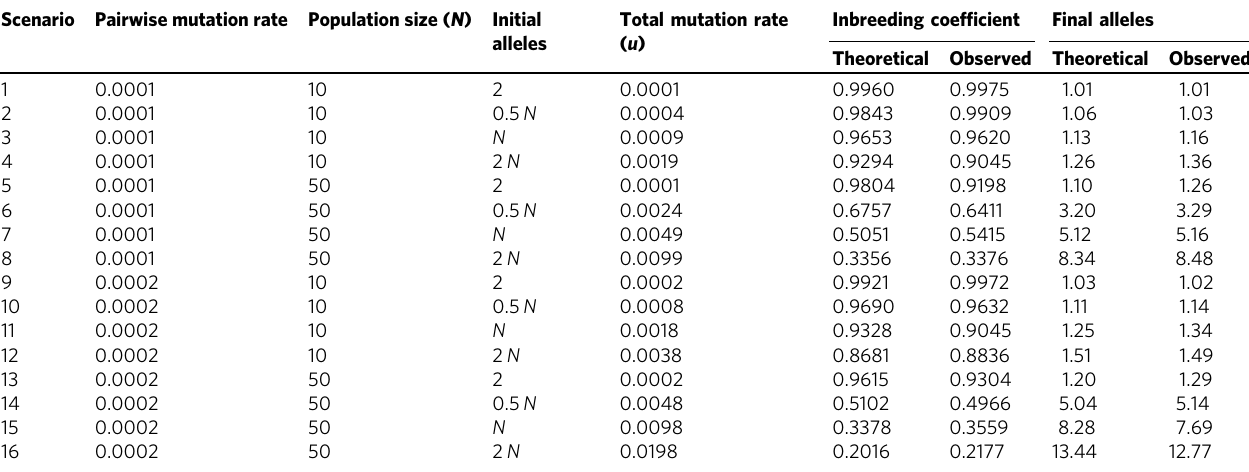
Table 1 Theoretical inbreeding coef fi cient and number of retained alleles at equilibrium, and observed inbreeding coef fi cient and number of retained alleles after 200 generations of random drift and neutral mutation. Scenario Pairwise mutation rate Population size ( N ) Initial